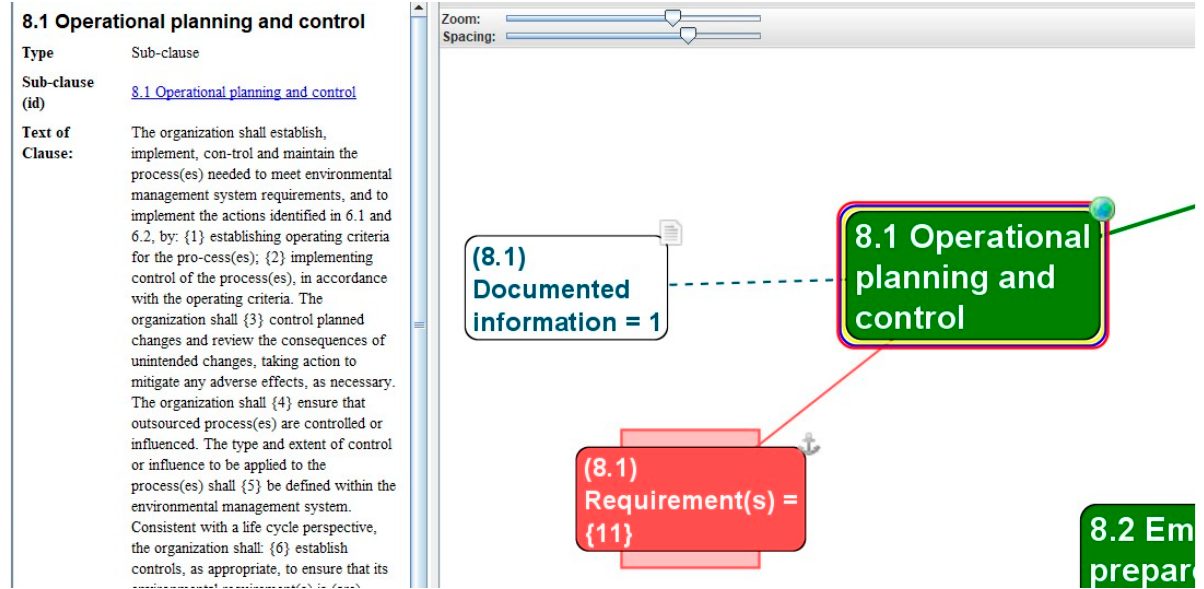
Figure 5. Overview of all the requirements { 11 } and Documented information/1 of Subclause 8.1— Operational planning and control for the ISO 14001 EMS, using a scan from the software TouchGraph Navigator (the cut-out) (source: authors).